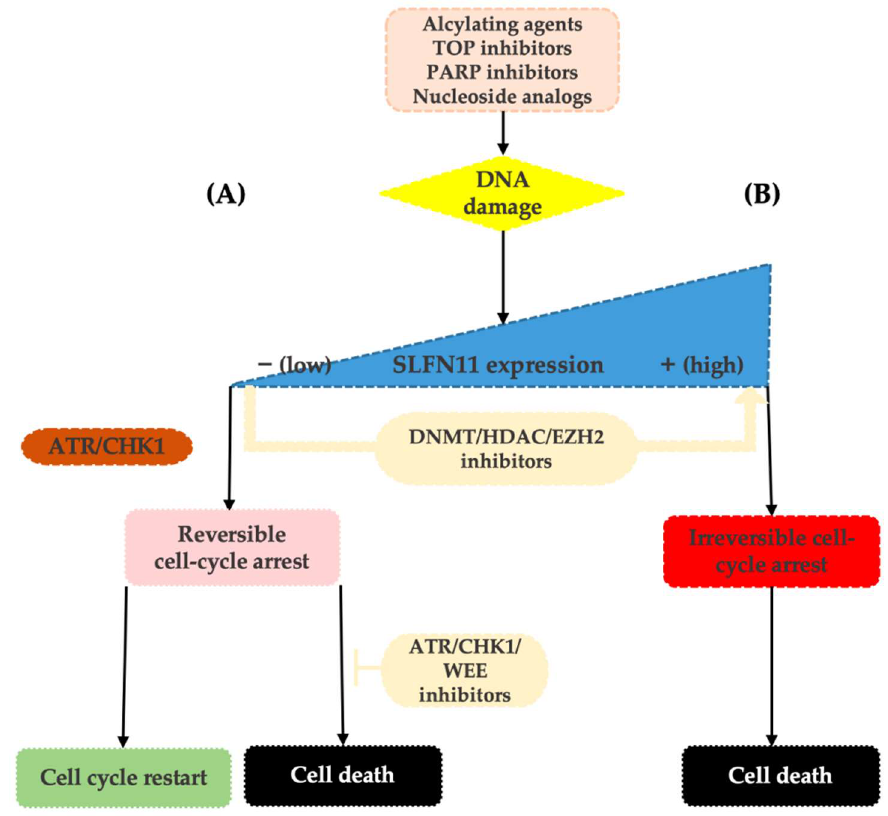
Figure 1. Upon replication stress caused by various types of DDA, SLFN11-proficient cells undergo an enforced G1/S arrest ultimately resulting in cell death ( B ). On the contrary, SLFN11-deficient cells reliant on the ATR/CHK1 pathway re-enter the cell cycle, slowly progress through the S-phase, and following DNA repair can survive ( A ). SLFN11 expression can be reactivated by the inhibitors of epigenetic modulators, such as DNA methyltransferase (DNMT), histone deacetylase (HDAC), or EZH2 inhibitors. Resistance of SLFN11-deficient cells can be overcome by combination with ATR/CHK1/WEE1 inhibitors.